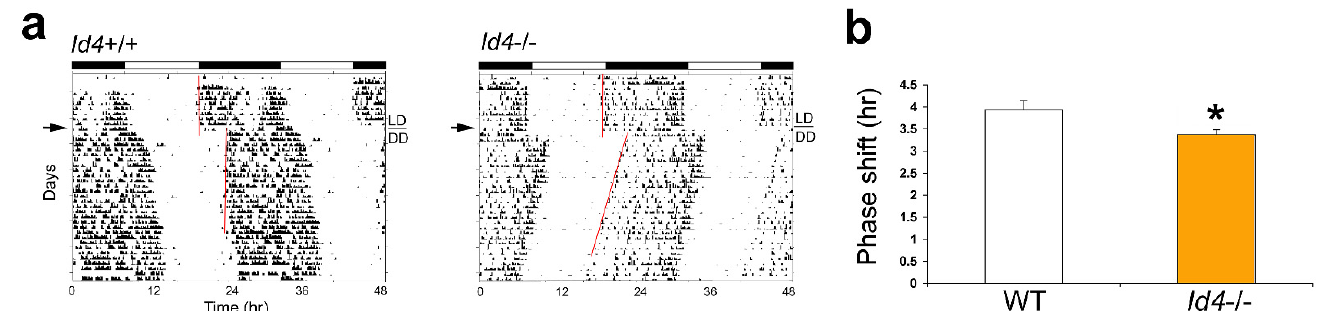
Figure 2. Id4 − / − mice show a reduction in the magnitude of phase delays in response to a 10-h extension of the light phase. ( a ) Locomotor activity records of wild-type ( Id4 +/+) and Id4 − / − mice exposed to a 10-h extension of the light phase of the light/dark (LD) cycle. Actograms are shown in double-plotted format with each horizontal line representing a 48-h period, and the second 24-h period plotted to the right and below the first. Vertical bars represent periods of wheel-running activity. Mice were exposed to 10 h of prolonged light exposure on day 1 and transferred to constant darkness (DD) for the remainder of the experiment. The line above DD on the right indicates the transition from LD to DD. The timing of the LD cycles is indicated by the white/black bars above the records. The arrow on the left indicates the actual day of treatment (Day 1). A line is fitted to the phase of activity onset for several days before and after the transfer to DD. ( b ) Mean ± SEM magnitude of the phase shifts produced by light treatment. Extrapolated activity onsets of the first day following the 10-h light treatment was used to determine the size of resultant phase delays. Wild type (WT; white), n = 19; Id4 − / − (orange), n = 15. * p < 0.05.